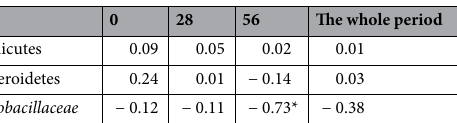
Table 4. Correlations between the microbiome of mothers and lambs in the studied periods. * p <